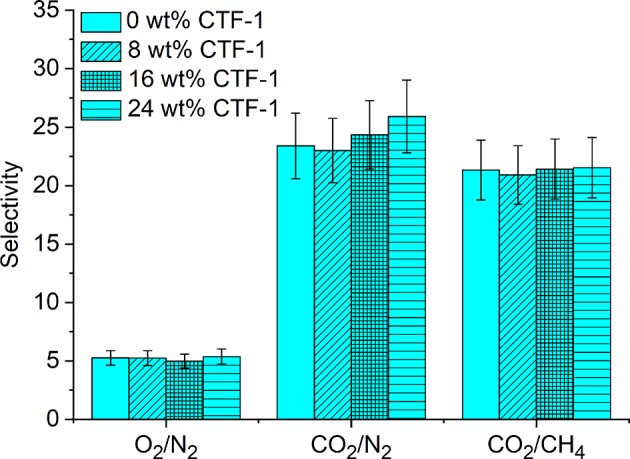
Gas selectivity of 0, 8, 16, and 24 wt% of CTF-1@PSF composite MMMs for O2, N2, CO2, and CH4.